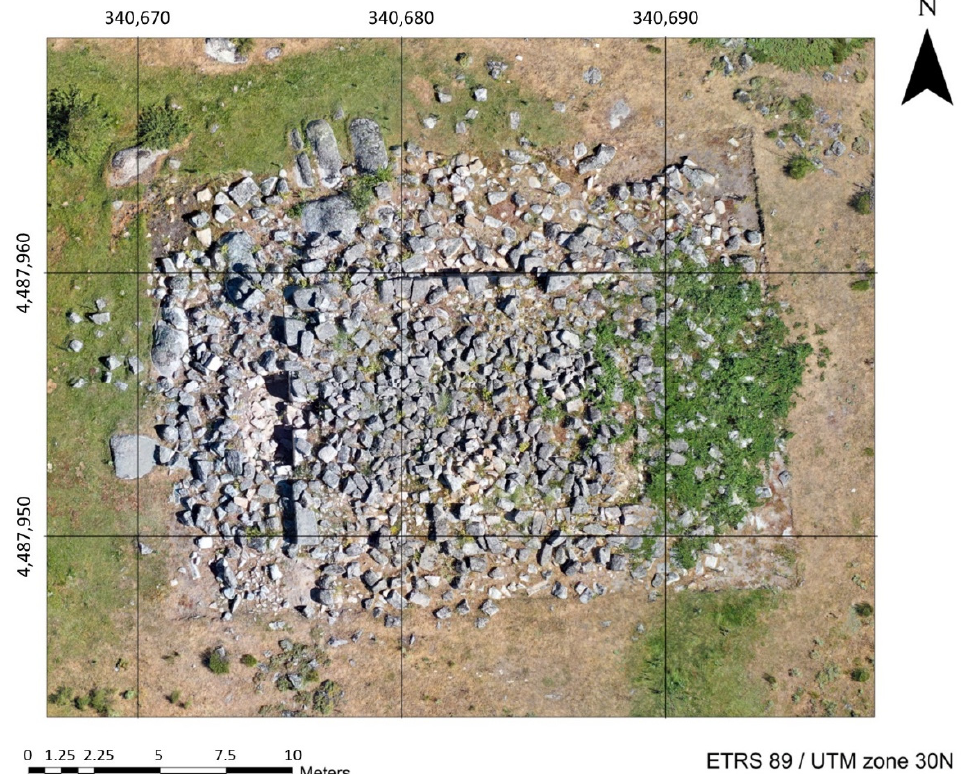
Figure 6. Detailed orthophoto of “El Torreón”.